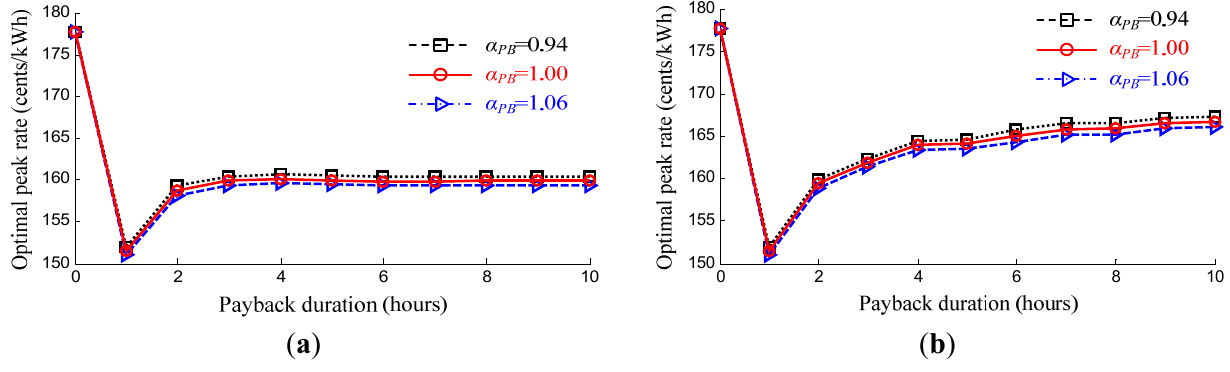
Figure 4. Simulation results of the optimal peak rate with respect to the payback duration